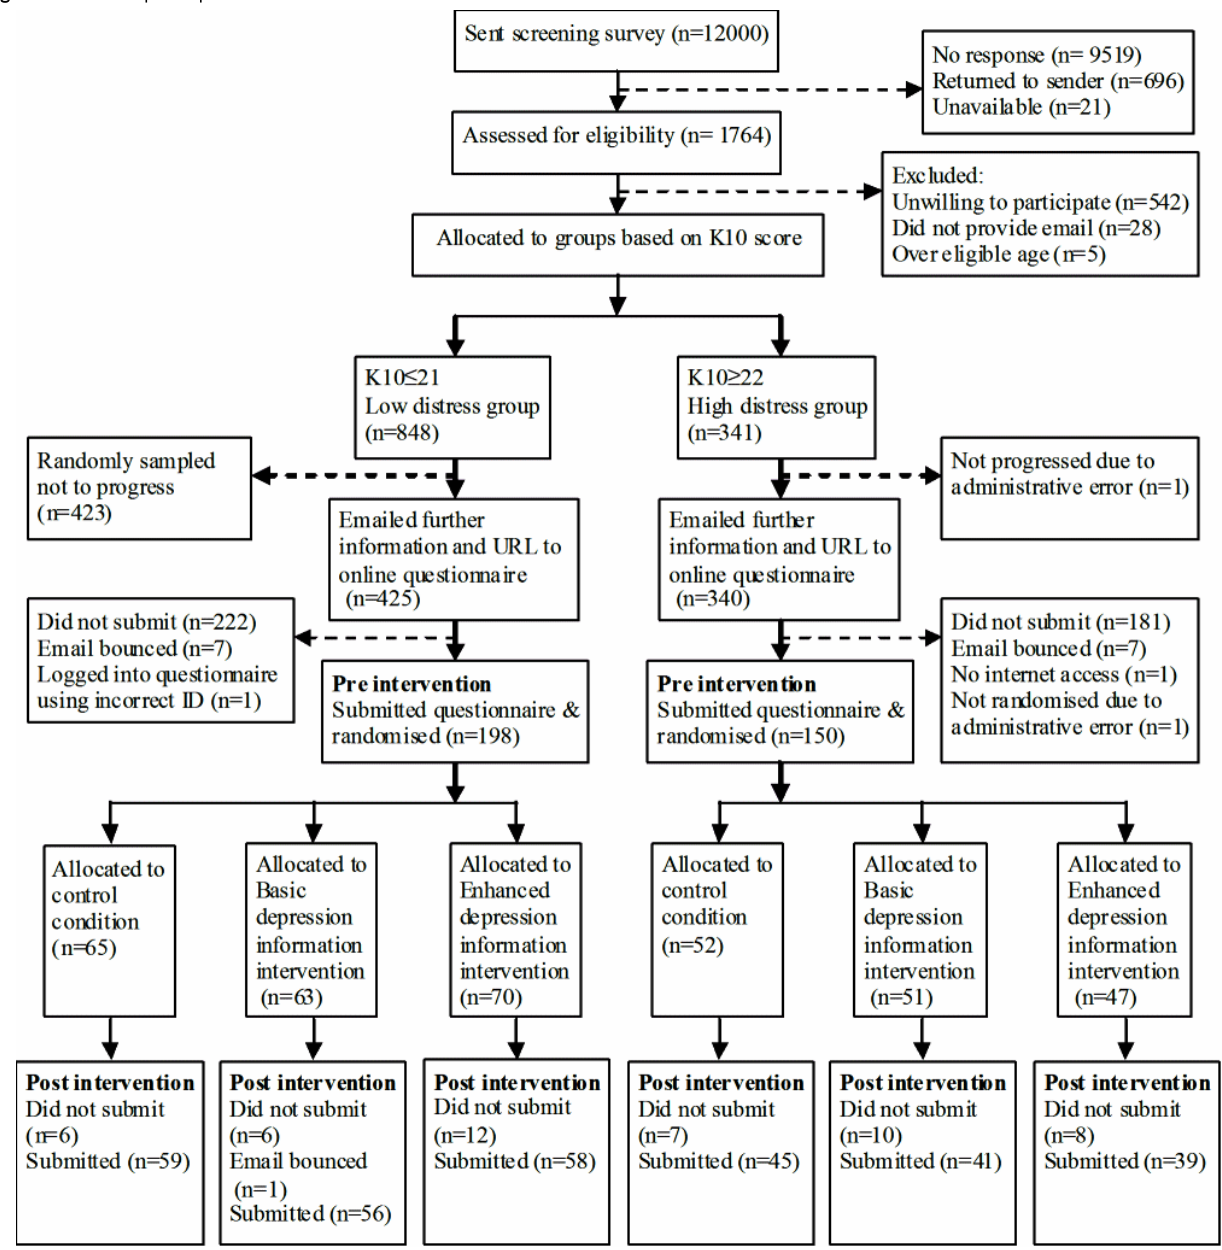
Figure 1. Flow of